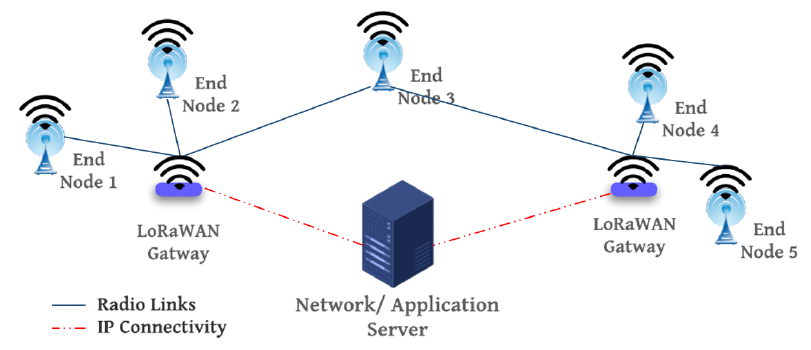
Figure 1. LoRaWAN network